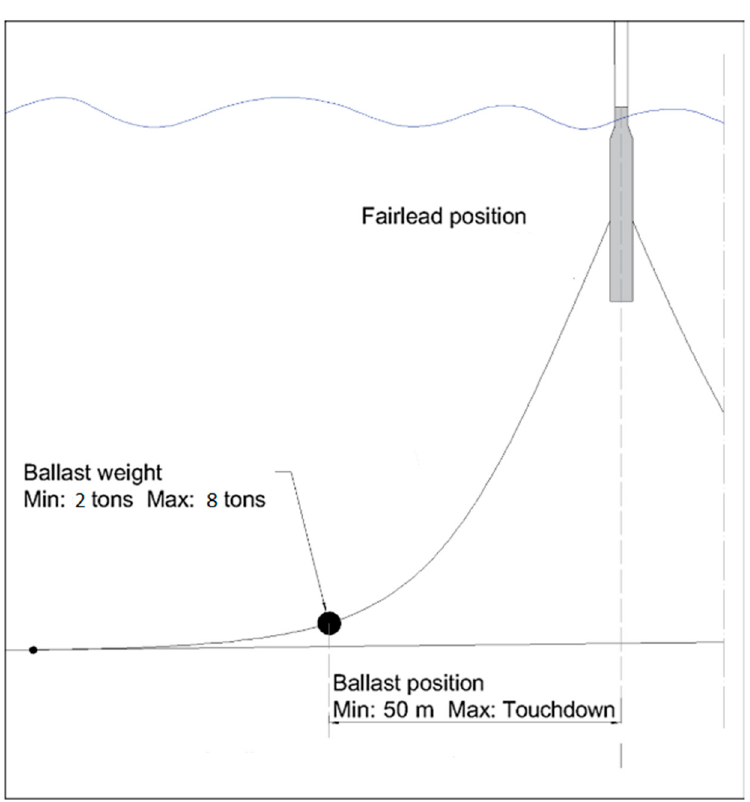
Figure 1. Scheme of the substructure system, platform plus mooring line (rearranged from [22]).